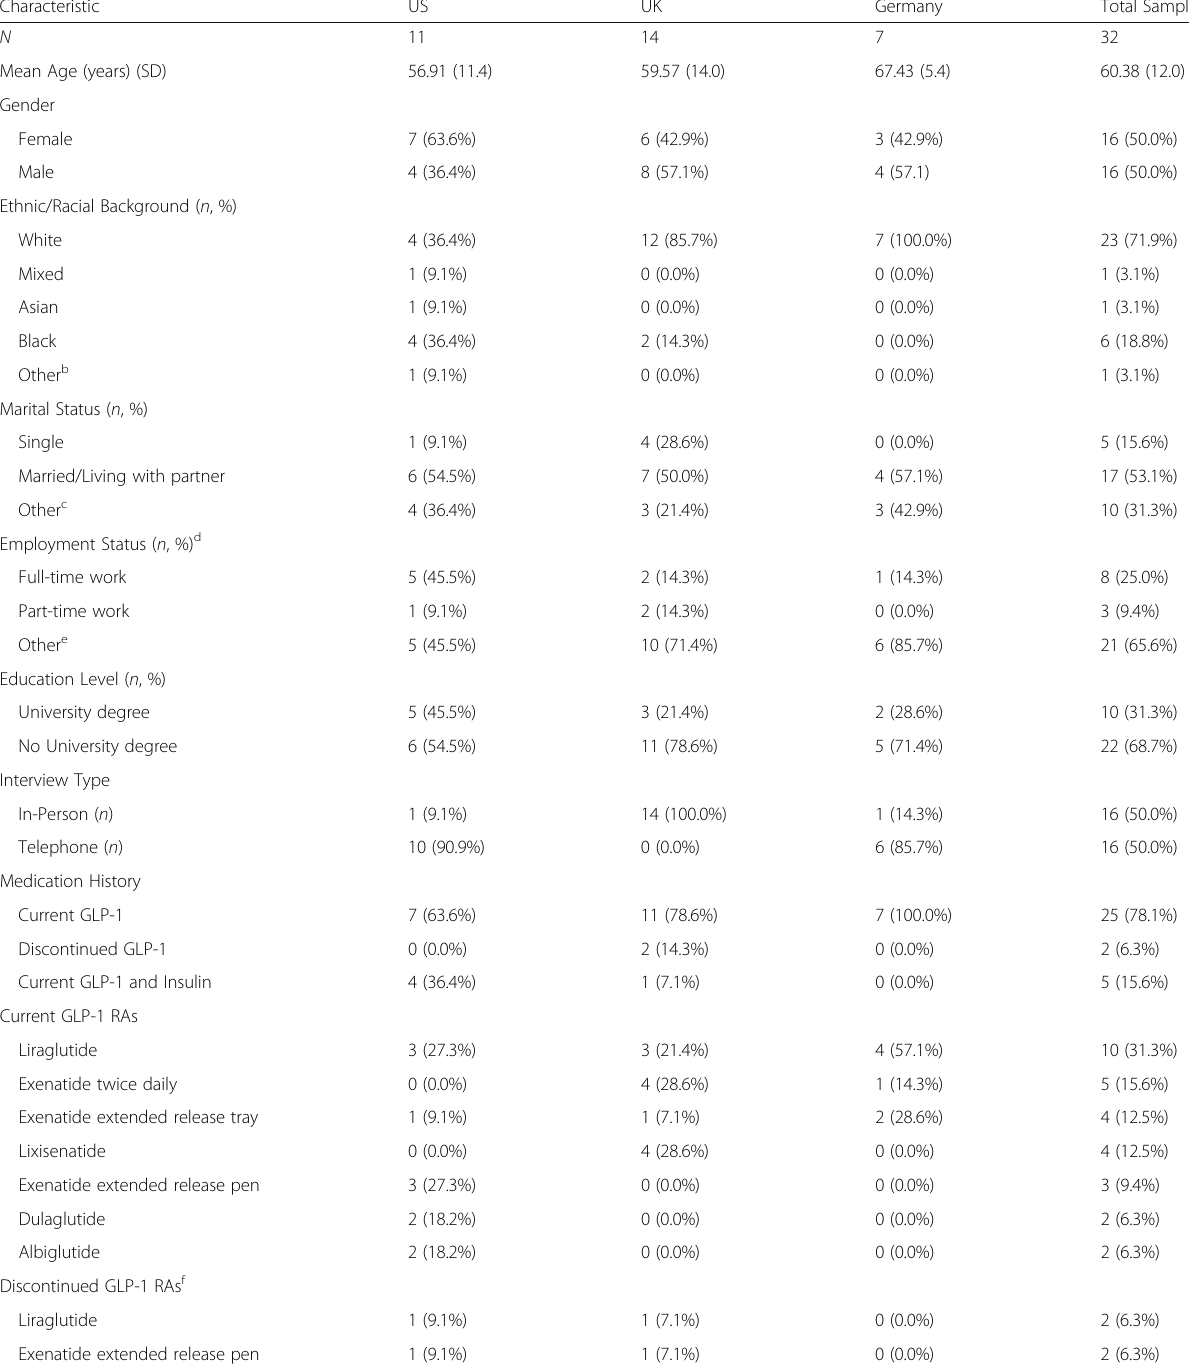
Table 1 Participant Characteristics (Concept